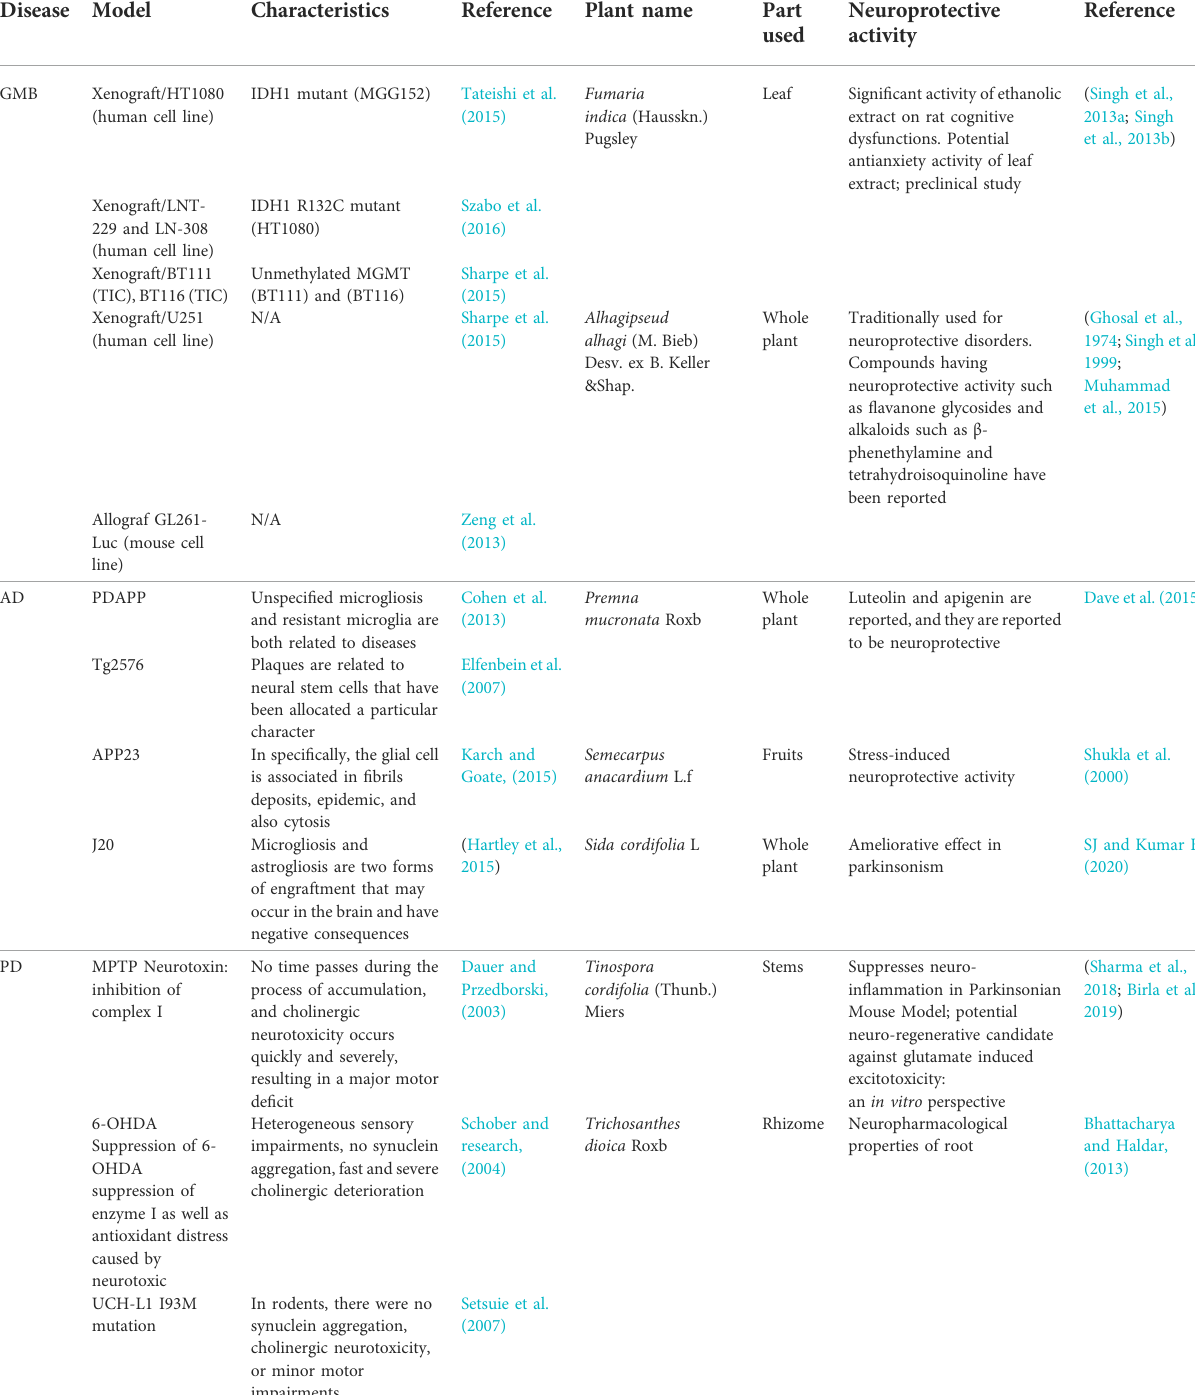
TABLE 3 Neuroendocrine tumor, sickness of Alzheimer, and disease of Parkinson animal models are